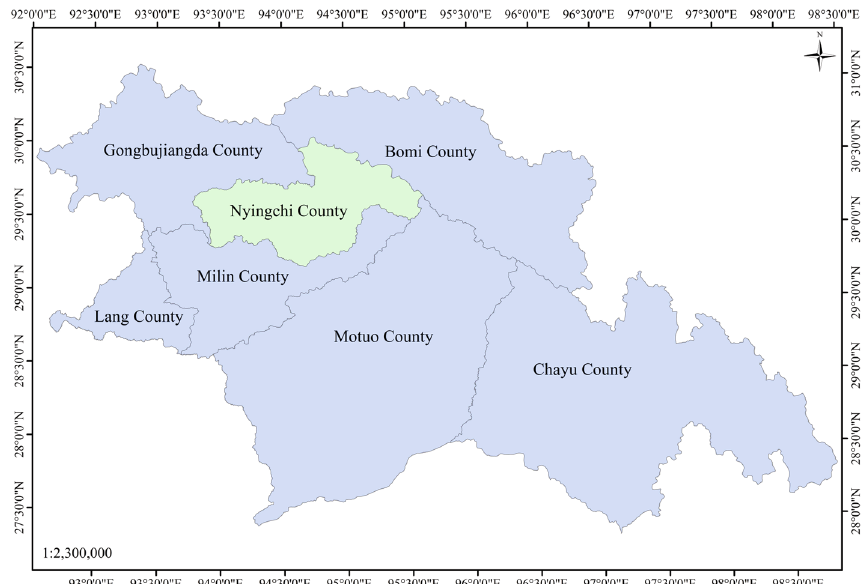
Figure 1. The location of Nyingchi County. The map is generated using ArcGIS 10.3 (http:// www. esri. com/ softw are/ arcgis/ arcgis- for- deskt